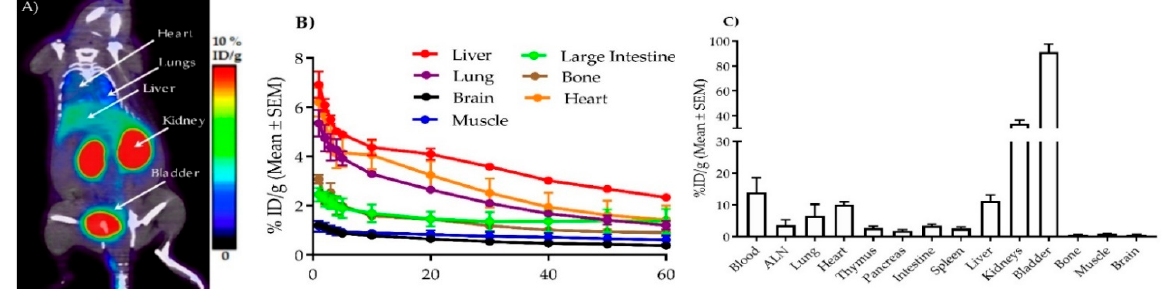
Figure 4. In vivo PET imaging of [ 18 F]FB-IL-2 in naïve Balb/c mice. ( A ) Whole-body PET-